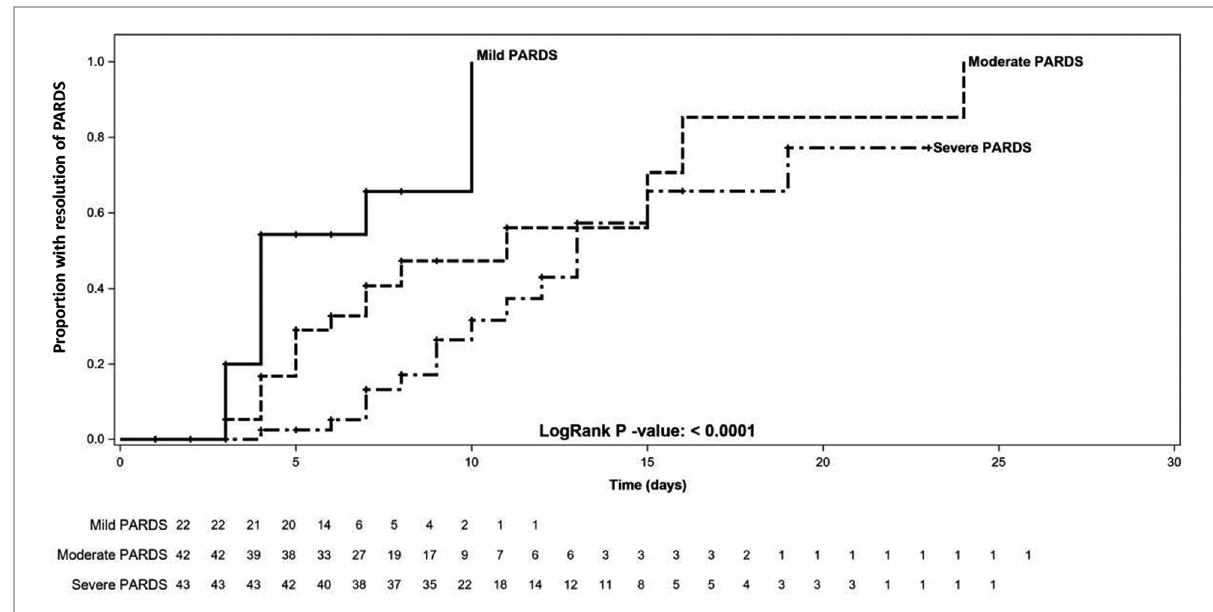
FIGURE 2 Kaplan – Meier curve of time to resolution of pediatric acute respiratory distress syndrome in patients with mild, moderate, and severe disease. PARDS, pediatric acute respiratory distress